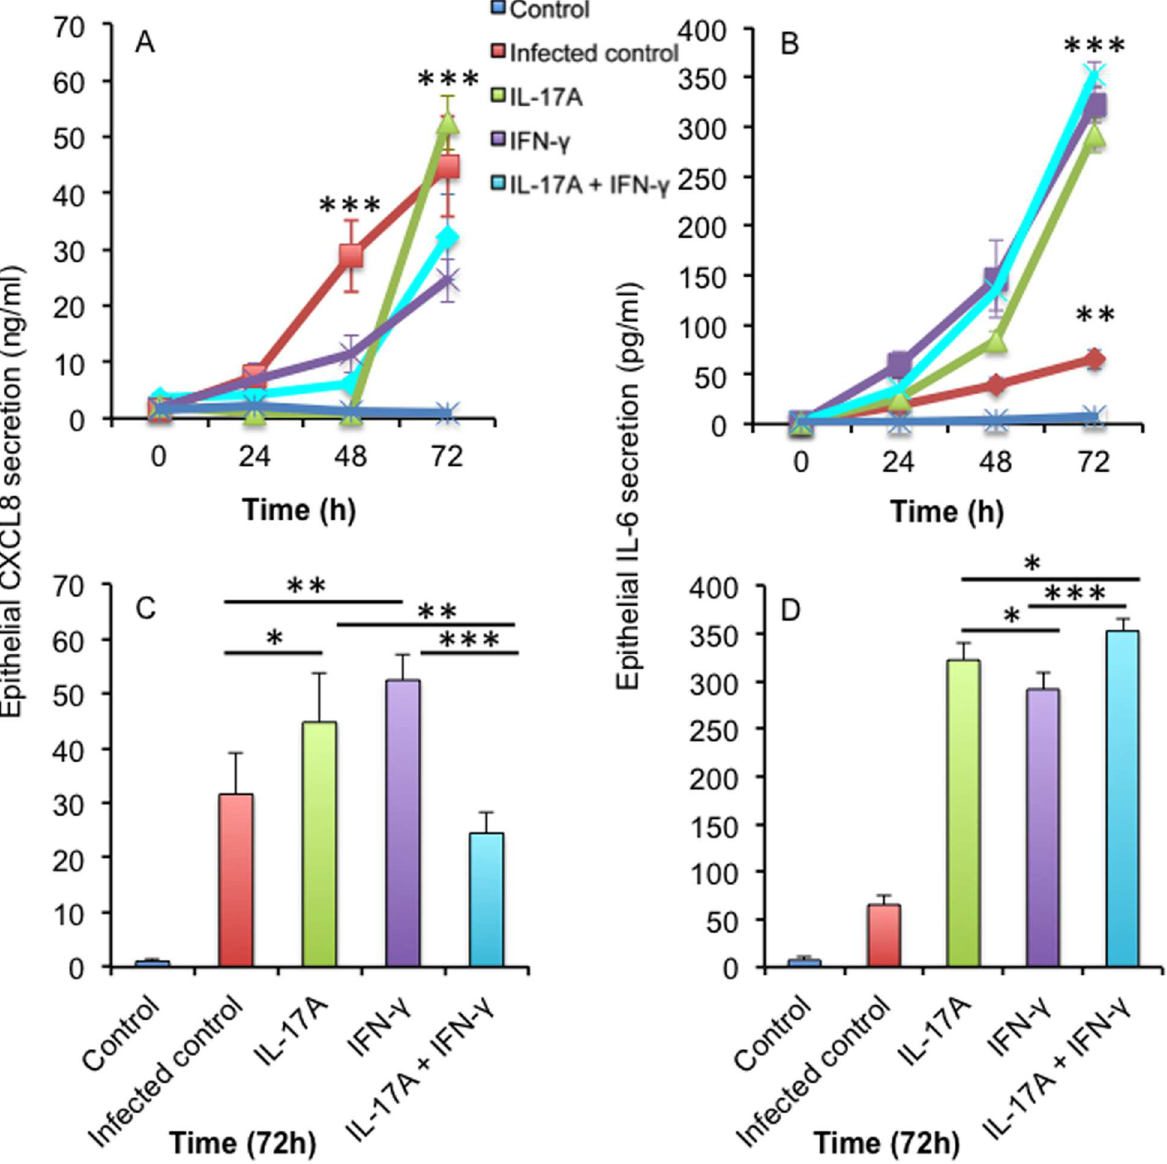
Fig 1. The effect of BCG infection on epithelial cytokine expression. (A) CXCL8 and (B) IL-6 productionfrom epithelialcells stimulated with BCG in combination with IL-17A and/or IFN- γ for 0, 24, 48 and 72 hours, MOI 1:1. The 72 hours time points are in additionrepresentedas bar graphs for (C) CXCL8 and (D) IL-6. The results are depicted as mean ± SD of three experiments. Means were compared with one way ANOVA followedby multiple comparisons test with Tukey’s correction and significancewas acceptedat * p < 0.05, ** p < 0.01, or *** p <